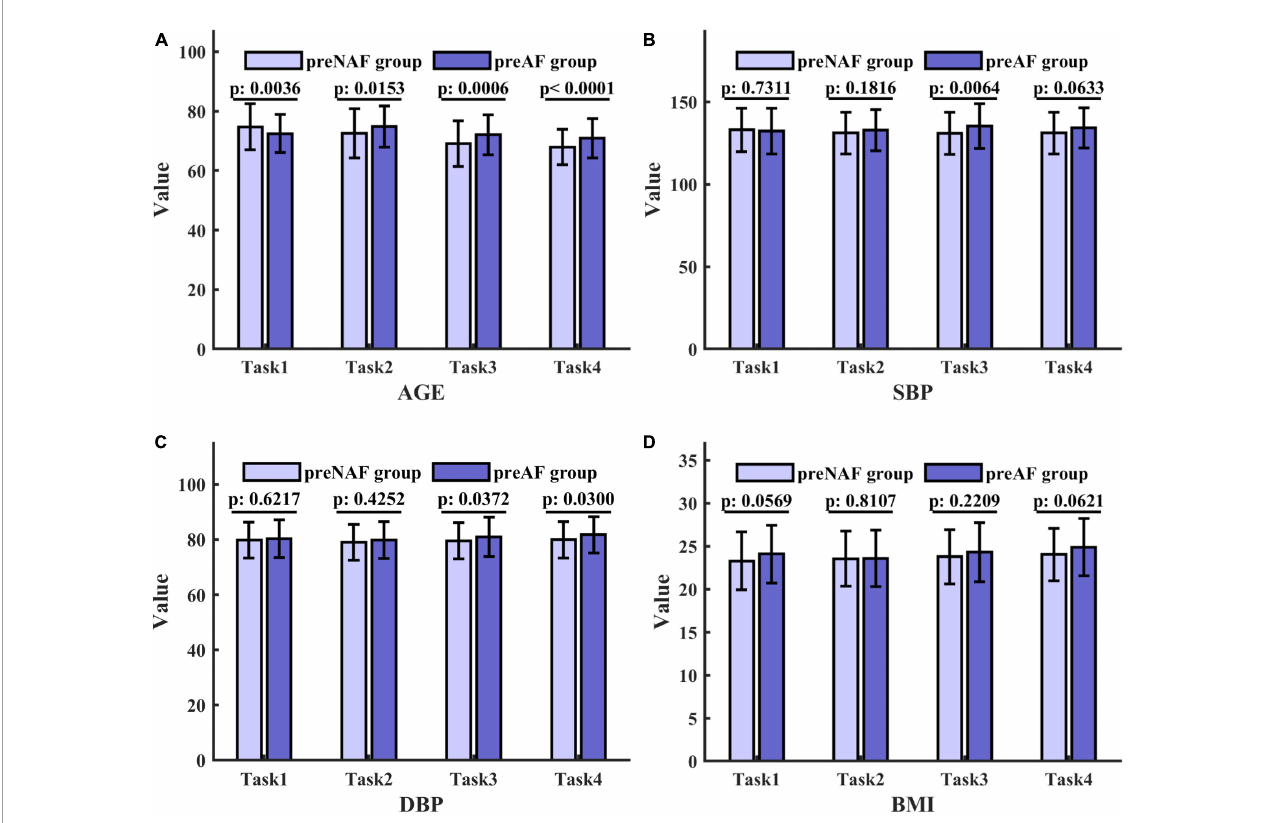
FIGURE3 Mean, error bars and p -values of 4 numerical variables in the pre_NAF group and pre_AF group in 4 tasks. The height of the columns represents the mean, and the error bar reflects the standard deviation. p values are obtained by the Mann–Whitney U test and indicate the existence of significant differences. (A) Age; (B) SBP; (C) DBP; (D)